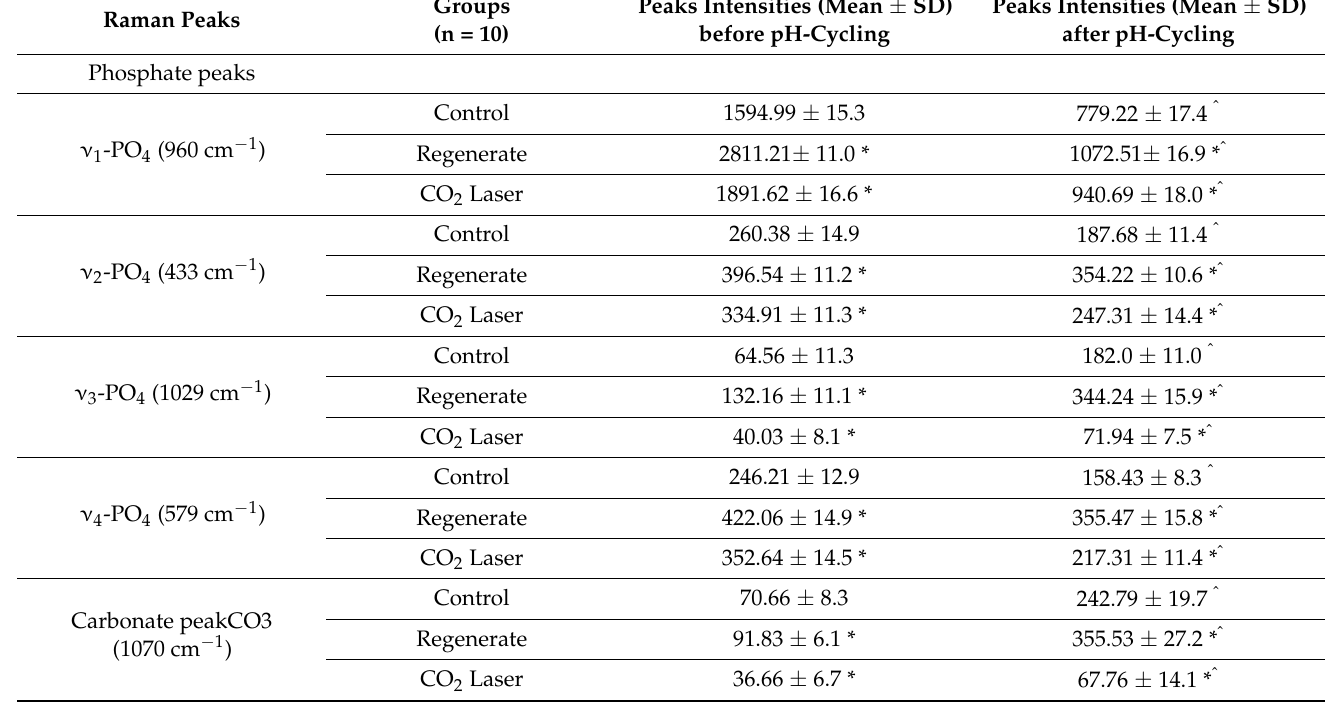
Table 1. Raman band intensities A.U. (Mean ± SD) of experimental groups (Control, regenerate system, CO 2 Laser) before and after